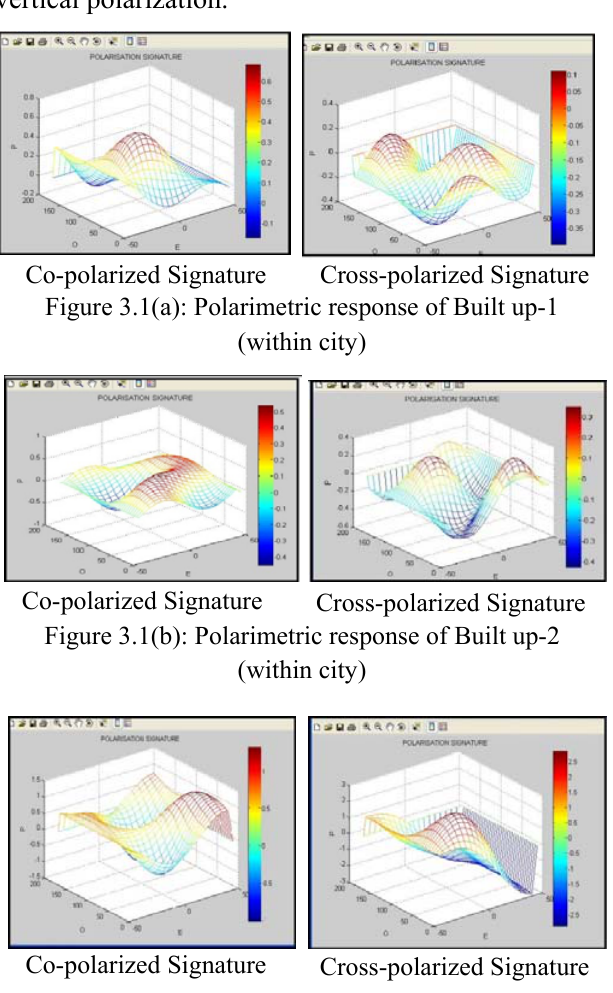
Figure 3.1(c): Polarimetric response of Built up within water